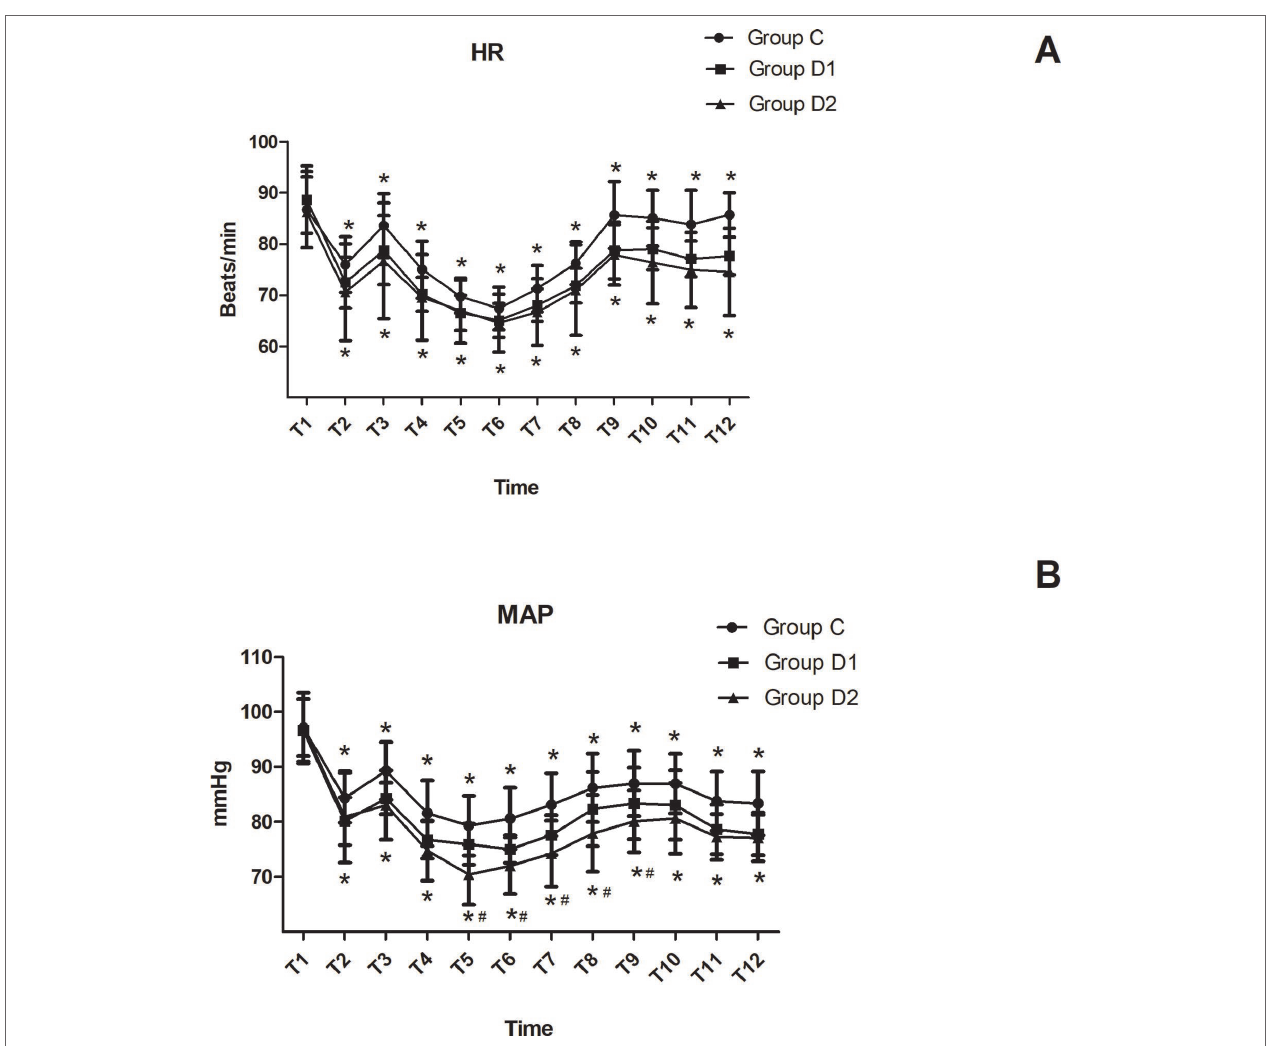
FIGURE 2 | Hemodynamics changes during the surgical procedure and post-anesthesia care unit (PACU) stay. (A) Comparison of HR in the three groups at different time-points. (B) Comparison of MAP in the three groups at different time-points. * P < 0.05 vs. Group C, # P < 0.05 vs. Group